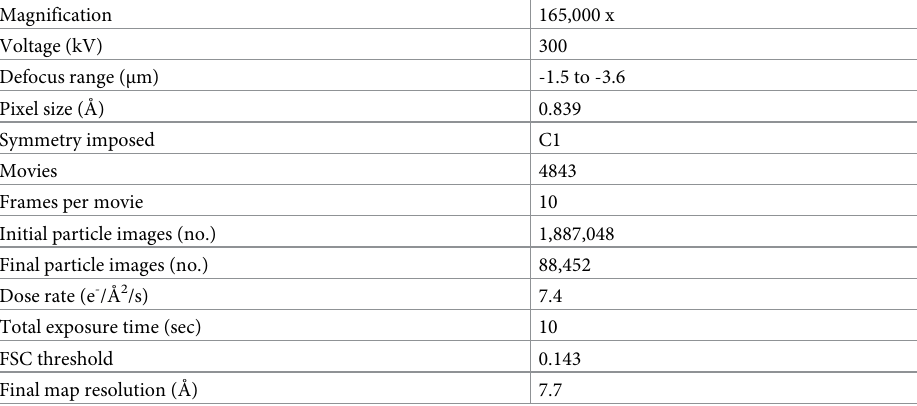
Table 1. Data collection and processing.